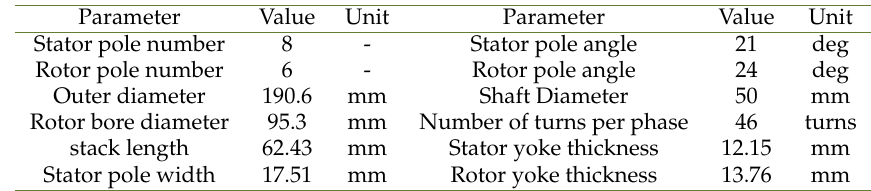
Table 2. Design Parameter values.